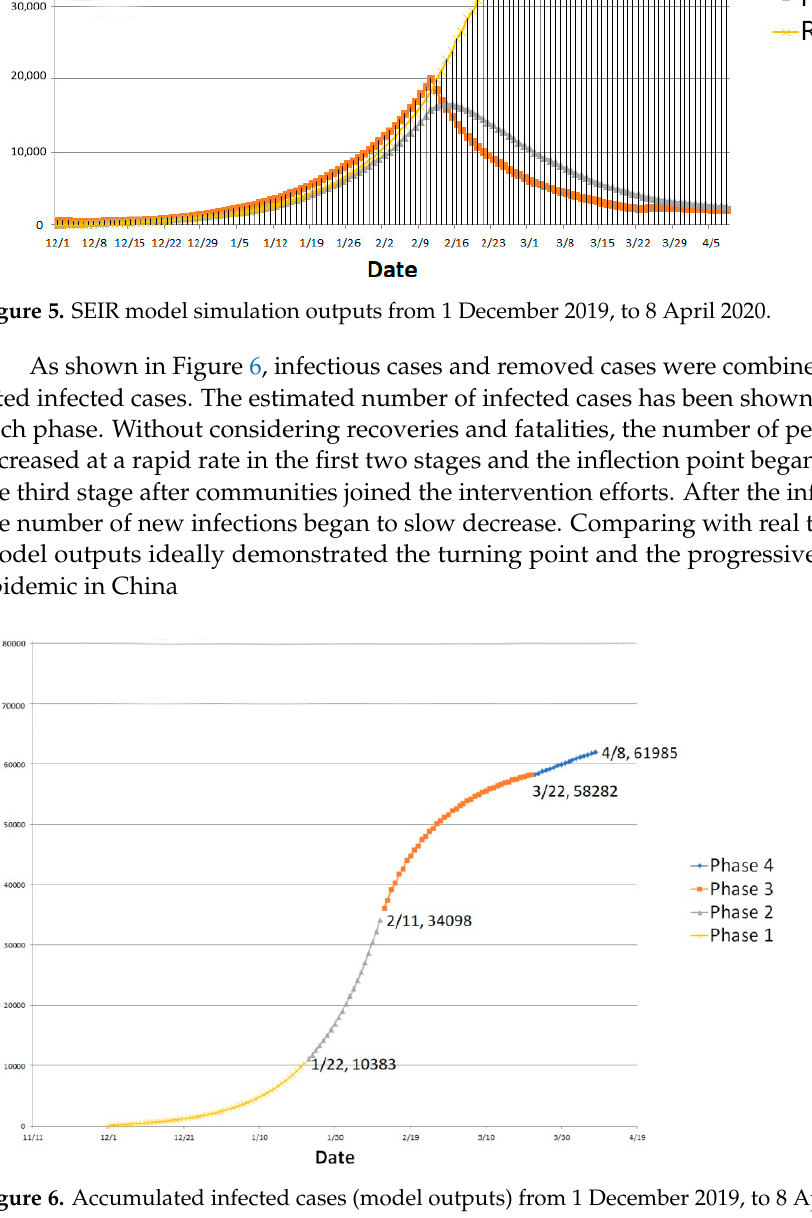
Figure 6. Accumulated infected cases (model outputs) from 1 December 2019, to 8 April 2020.